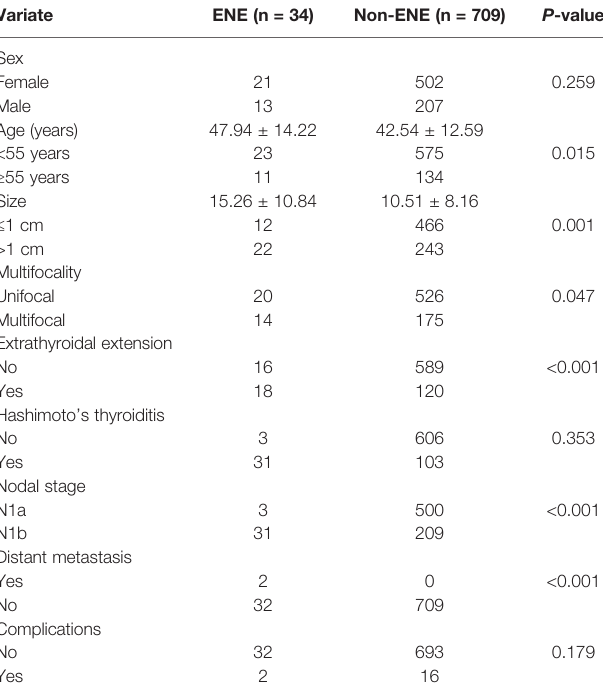
TABLE 1 | Baseline characteristics of the PTC